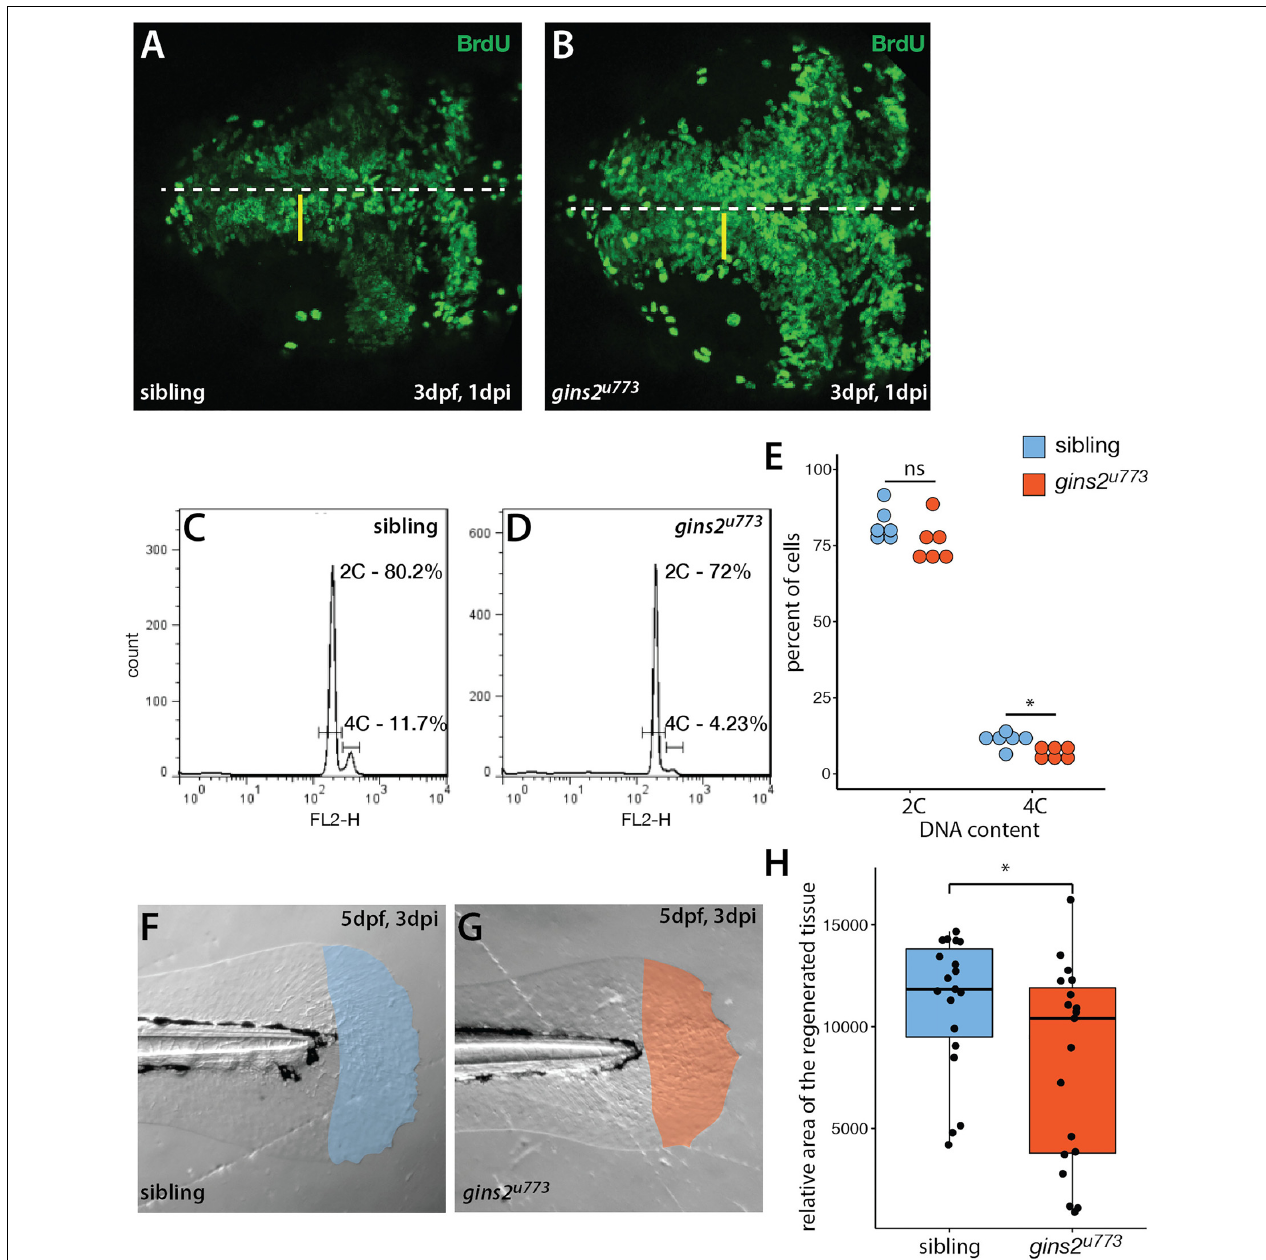
FIGURE 5 | gins2 u773 mutants show cell proliferation defects. (A,B) The intensity of fluorescence of BrdU labeling in the OT of a 3 dpf wildtype embryo shows a medio-lateral gradient. In contrast, mutant embryos showed a uniform distribution of the BrdU label. Dorsal views of the OT are shown, with anterior to the left. Midline is marked by the dashed line, yellow bars denote the proliferative area with a medial to lateral gradient of fluorescence in wildtype. (C,D) Representative histograms of flow cytometry analysis of wildtype and mutant samples. (E) DNA content analysis of propidium-iodide-labeled cells isolated from the head region showed no obvious change in the number of cells with 2C ( p = 0.15, n = 6), and a slight, but significant decrease in the number of cells with 4C ( p = 0.01, n = 6 independent samples). (F,G) Regenerated area of the caudal fin in wildtype siblings and mutant embryos following amputation at 2 dpf. (H) At 3 days post injury